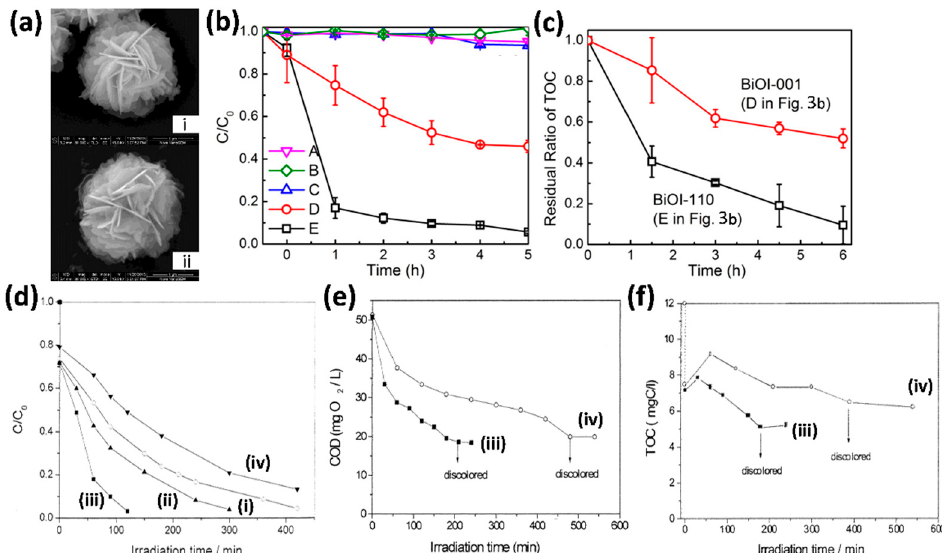
Figure 3. ( a ) TEM images of ( i ) BiOI-110 and ( ii ) BiOI-001. ( b ) Photodegradation of BPA and ( c ) reduction of TOC under different conditions: A—without photocatalyst and visible light, B—with BiOI-001 in the dark, C—with BiOI-110 in the dark, D—with BiOI-001 and visible light, and